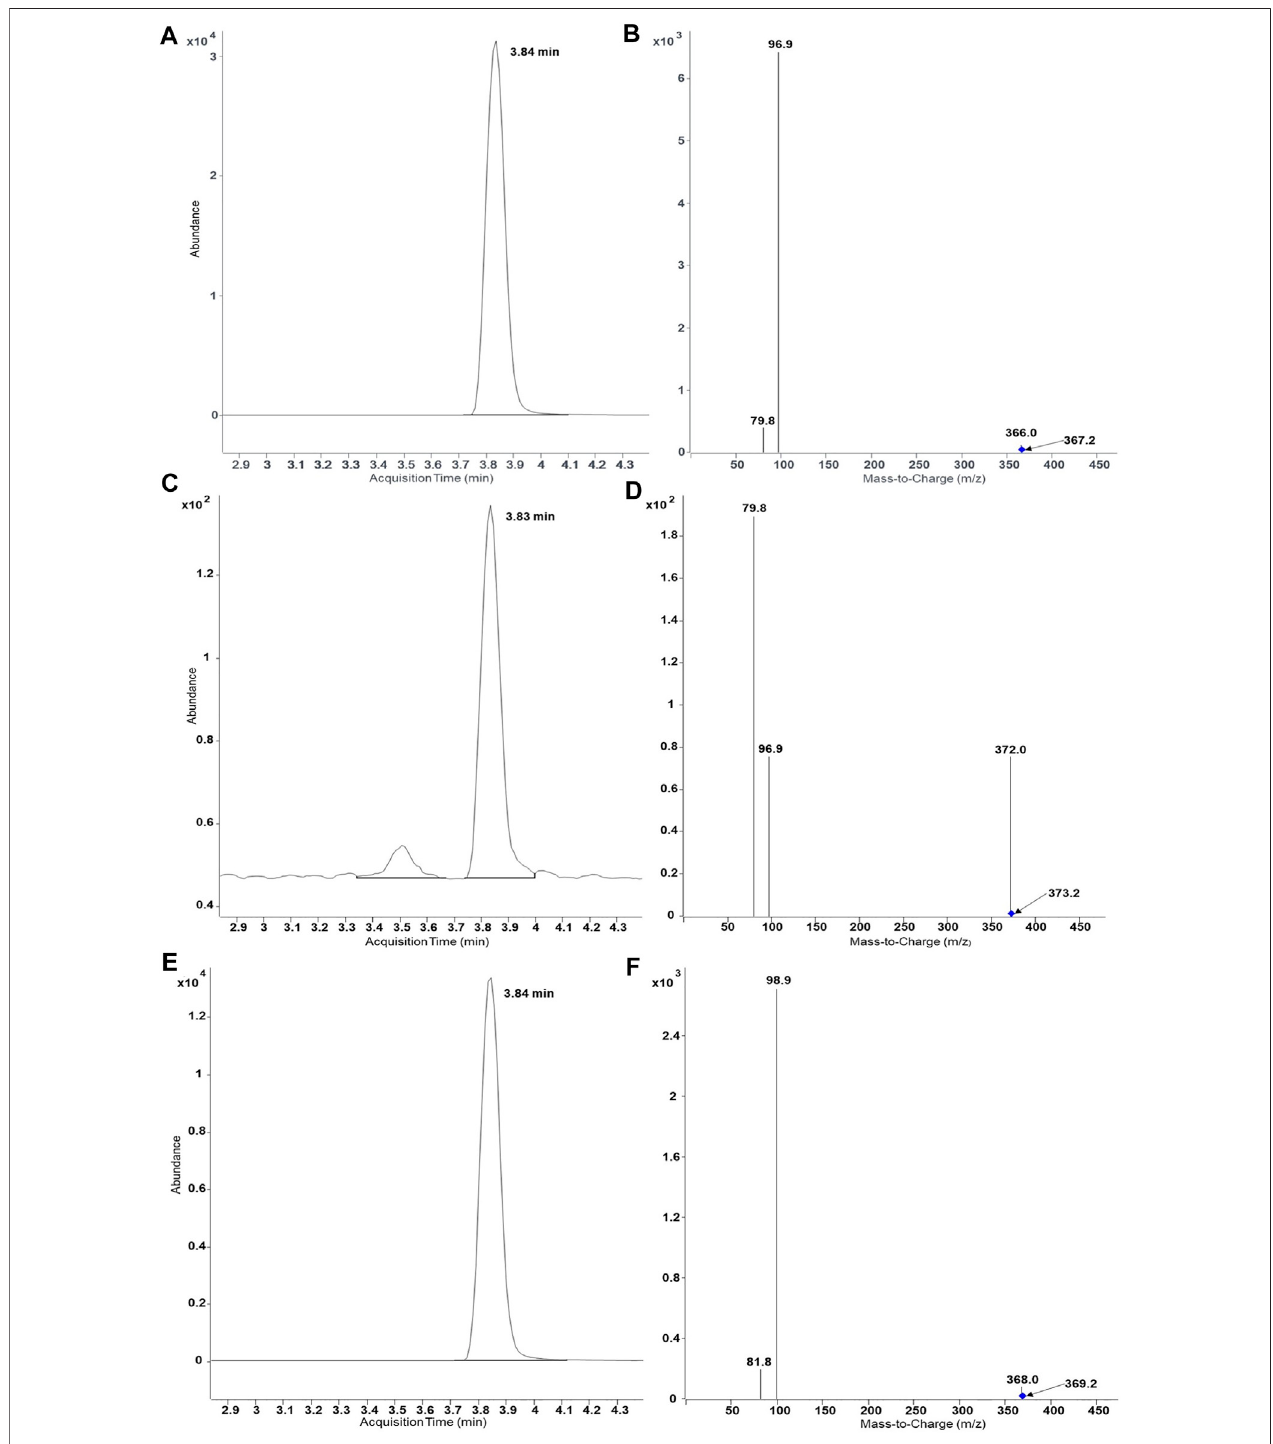
FIGURE 4 | UHPLC-MS/MS results of biosynthesis of DHEASU, D 6 -DHEASU, and DHEA- 34 S-SU by SULT2A1 (YN4). Product ion spectra generated in ESI − are dominated by the fragment HSO 4 − (96.9) or H 34 SO 4 − (98.9). (A) Chromatogram of DHEASU displaying quali fi er transition m/z 367.2 → 96.9; (B) MRM transitions in DHEASU assay ( m/z 367.2 → 366, 367.2 → 96.9 and 367.2 → 79.8); (C) Chromatogram of D 6 -DHEASU displaying quali fi er transition m/z 373.2 → 96.9 (D) MRM transitionsinD 6 -DHEASUassay( m/z 373.2 → 372,373.2 → 96.9and 373.2 → 79.8); (E) Chromatogram ofDHEA- 34 S-SUdisplayingquali fi ertransition m/z 369.2 → 98.9; (F) MRM transitions in DHEA 34 SU assay ( m/z 369.2 → 368, 369.2 → 98.9 and 369.2 → 81.8).